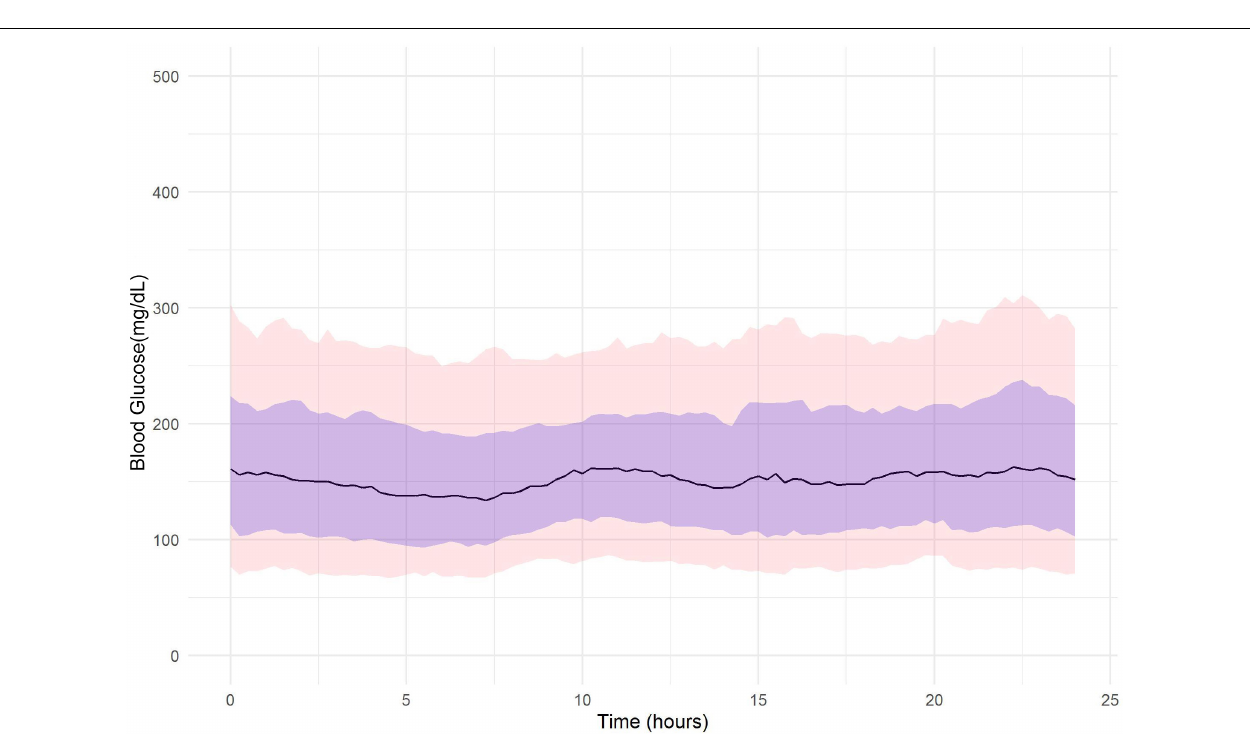
FIGURE 2 | FGM glucose profile ( n = 24) in 30 days during COVID-19 lockdown and pre-Ramadan (20 March 2020– 18 April 2020). Line indicates median glucose and purple shaded area shows 25 and 75th percentiles. Pink area denotes 10 and 90th percentiles.